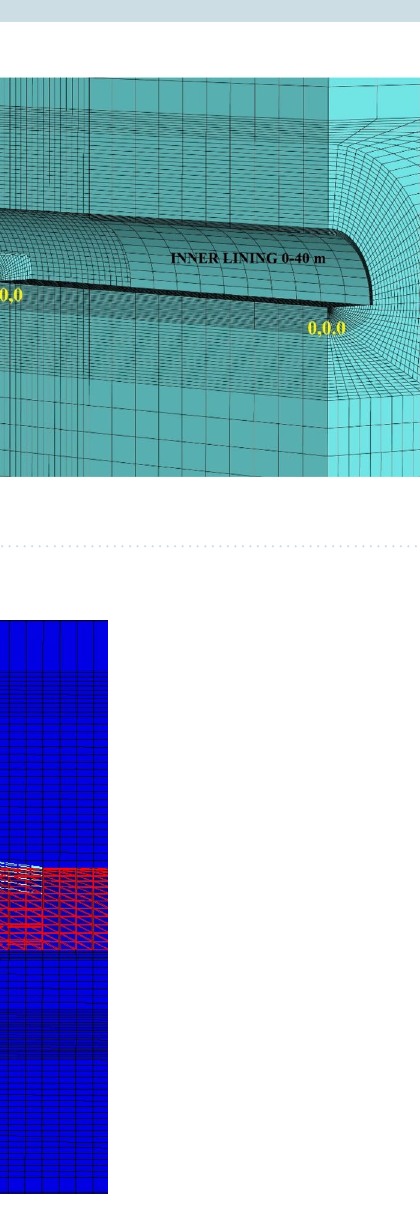
Figure 17. Face bolts and umbrella systems in the top heading section.